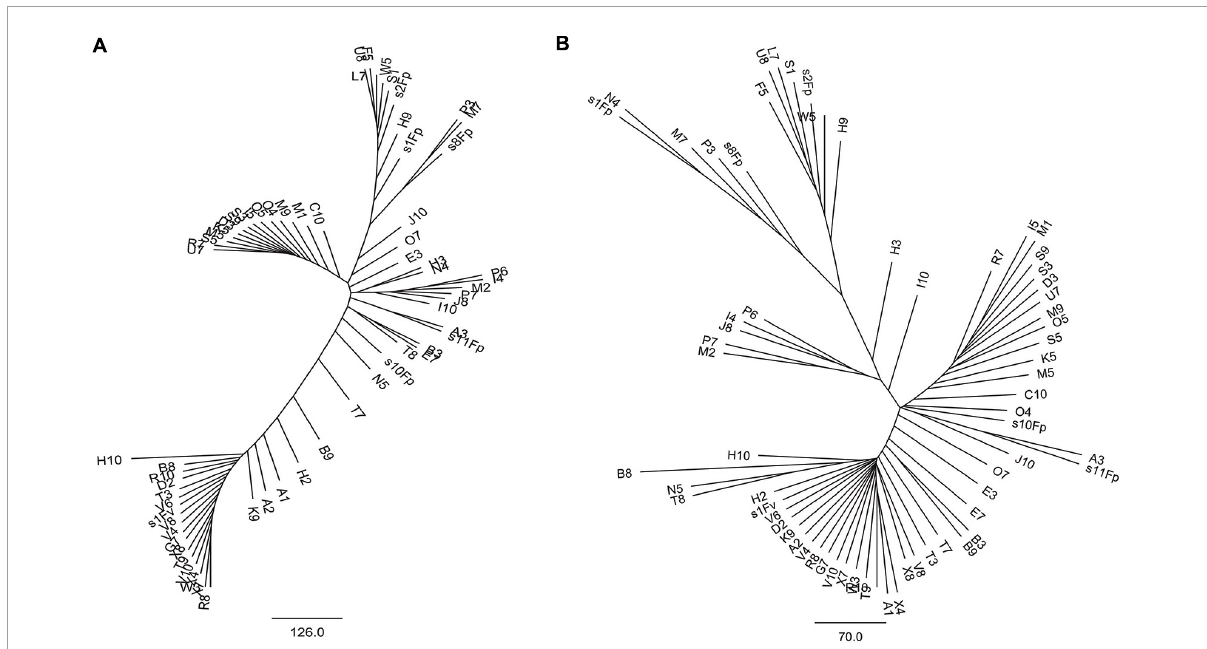
FIGURE2 Radial neighbor-joining phylogenetic tree of genetic diversity within Fusarium proliferatum . (A) Genomic phylogeny determined based on SNP differences using whole-genome alignments of 67 strains to the reference strain Fp9. (B) Genomic phylogeny constructed based on SNP differences using FUM -cluster alignments of 67 strains to the reference strain Fp9. Branch lengths were proportional to the number of segregating sites that differentiated each pair of strains.